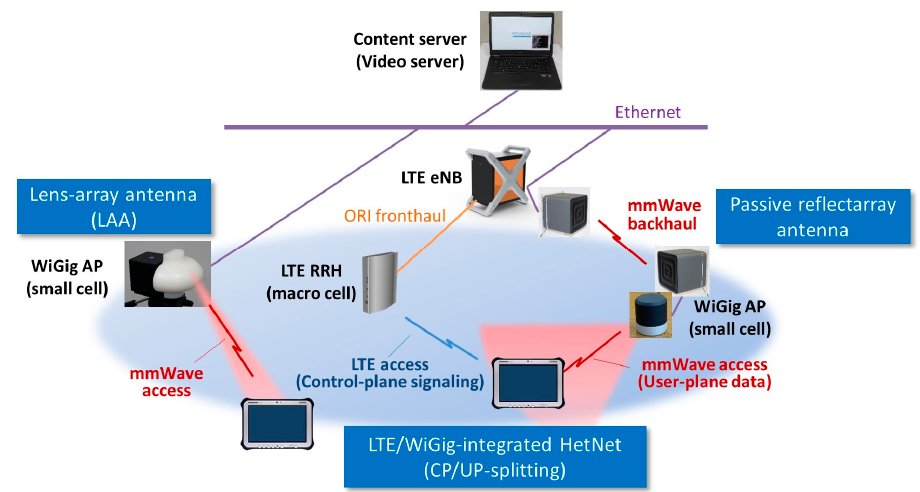
Figure 10. Overall illustration of mmWave-integrated HetNet PoC. Sensors 2016 , 16 , 1362